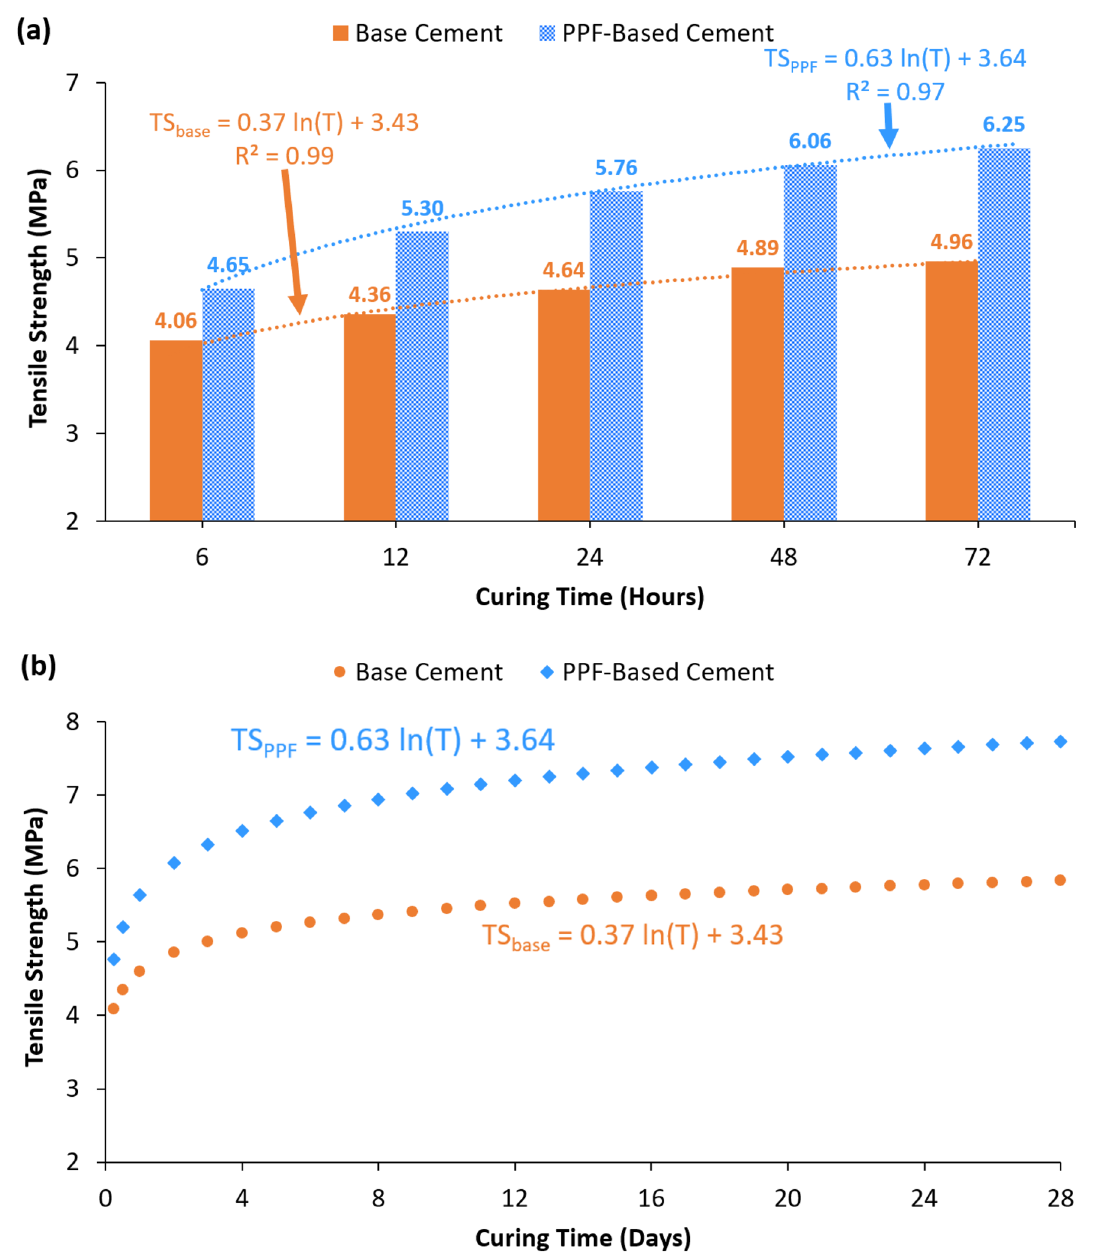
Fig. 5 Tensile strength for the polypropylene and base specimens at various stages of curing. a The findings of the tensile strength during the early curing times. b The anticipated variations in tensile strength over 4